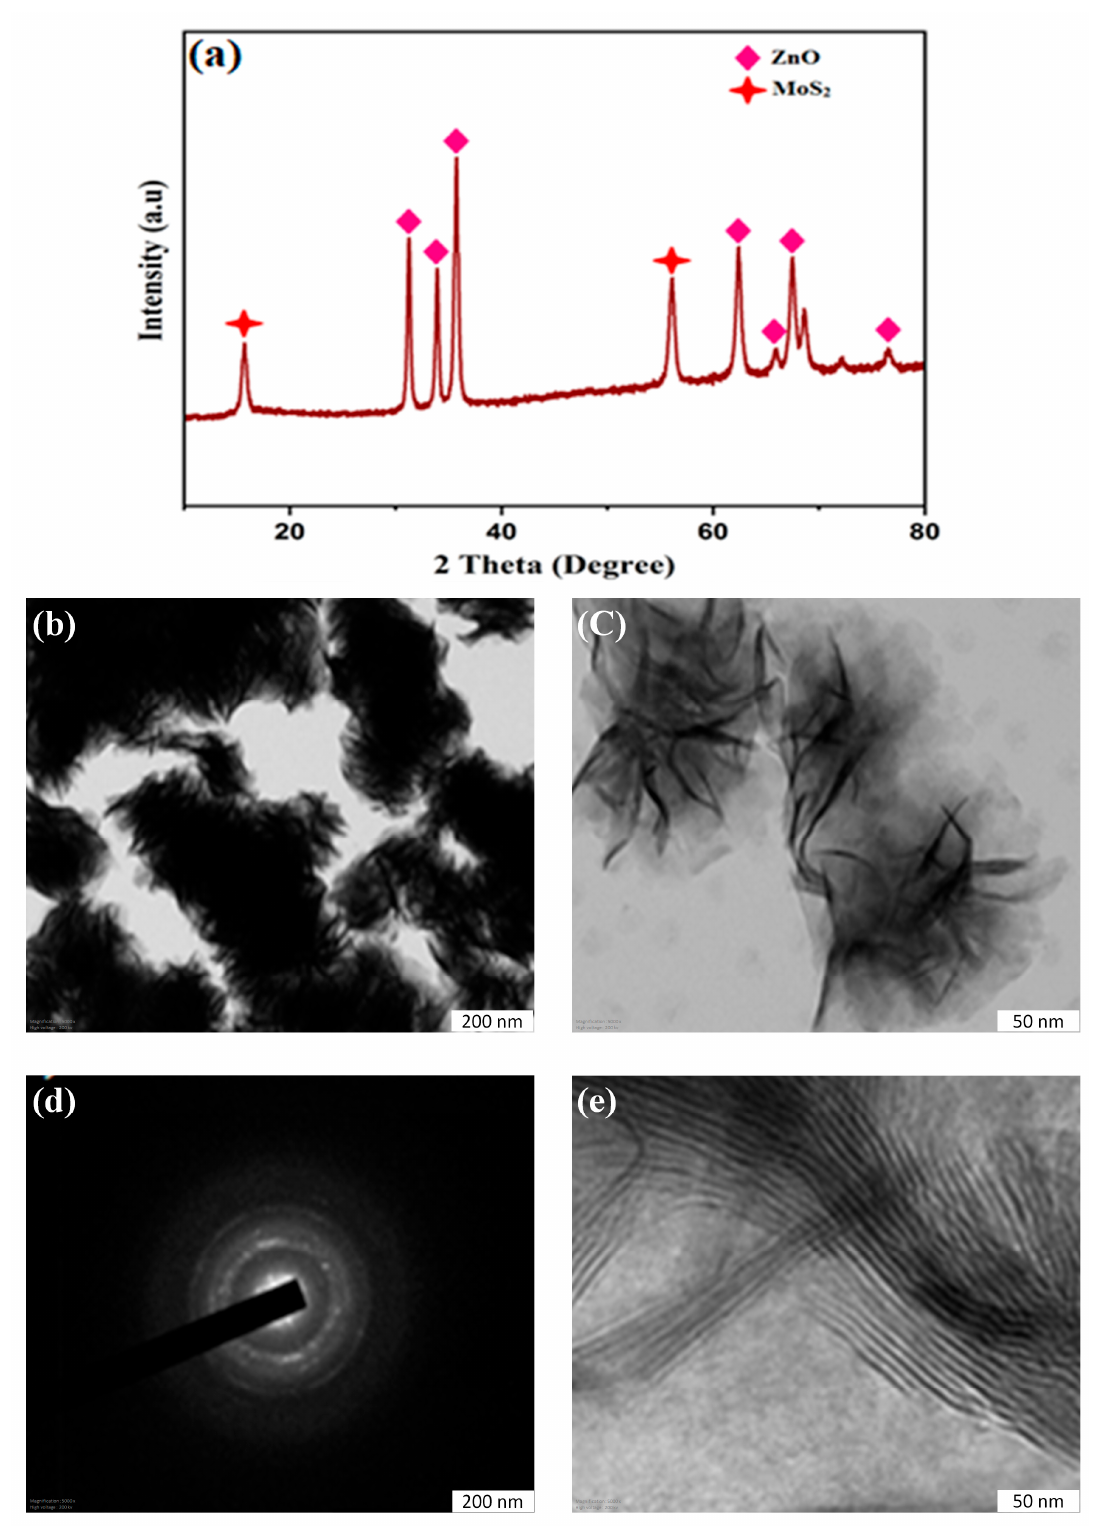
Figure 1. ( a ) XRD patterns of MoS 2 /ZnO nanocomposite. ( b ) HR-TEM image of exfoliated flower- structured MoS 2 nanosheets. ( c ) HR-TEM image of fl ower-structured MoS 2 nanosheets in high-resolution. ( d ) MoS 2 nanosheets for selected area electron di ff raction (SAED) pa tt ern. ( e ) HR-TEM image of MoS 2 la tt ice fringes.